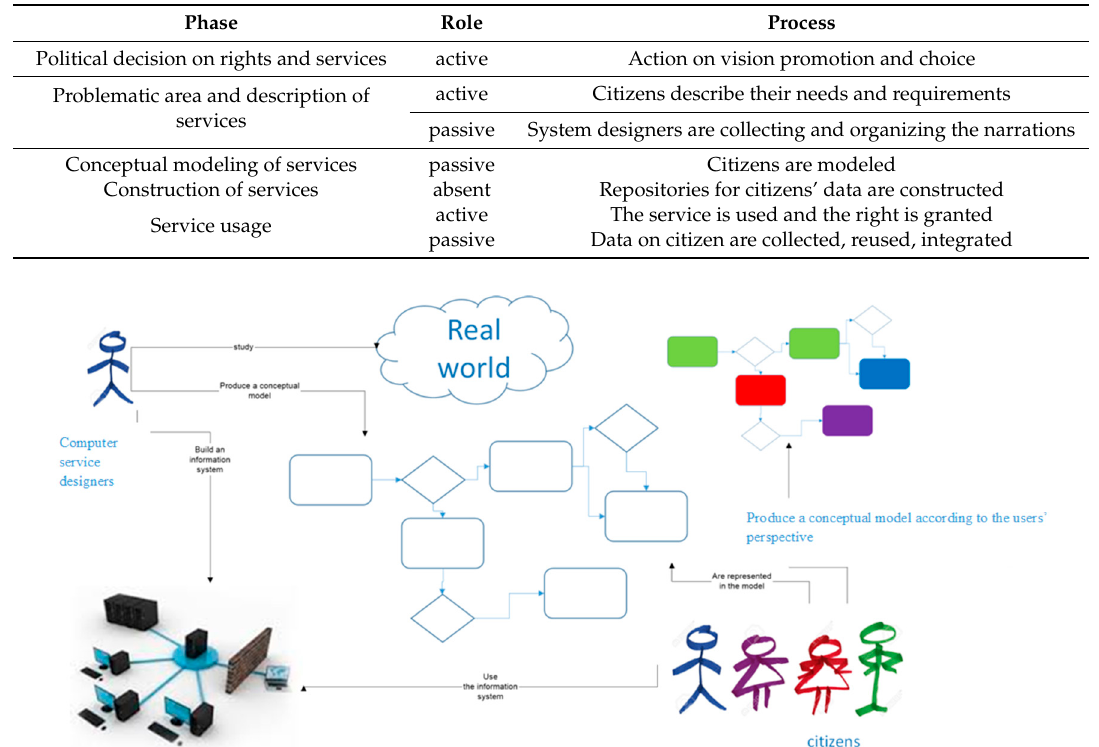
Figure 2. Smart services conceptual models as per the users’ perspective.